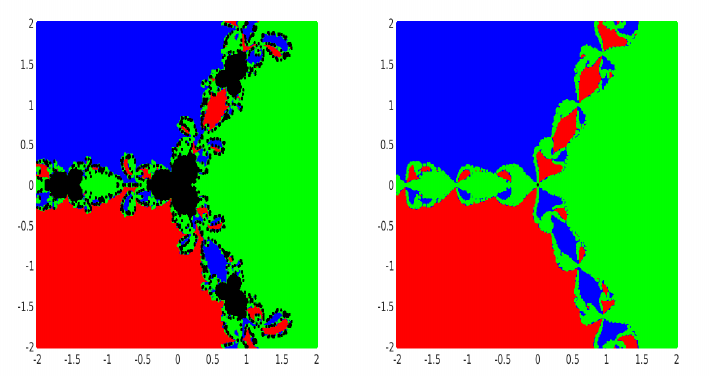
Figure 4. Dynamical plane of the methods (3) (left) and (4) (right) with basins of attraction for Example